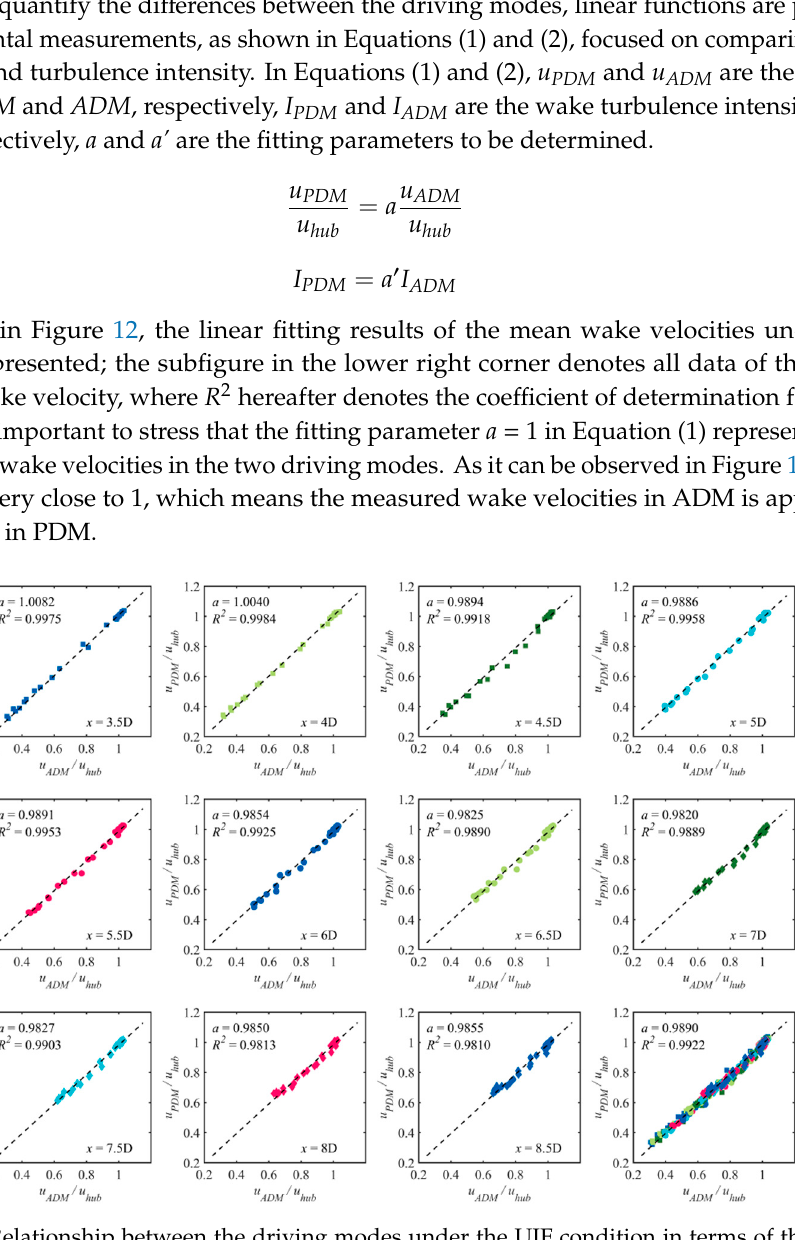
Figure 12. Relationship between the driving modes under the UIF condition in terms of the mean wake velocity.